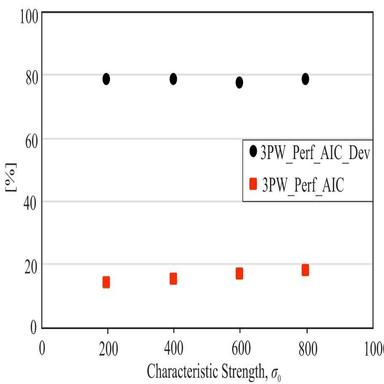
Fitting performance of 3P-Weibull distribution function as a function of characteristic strength.